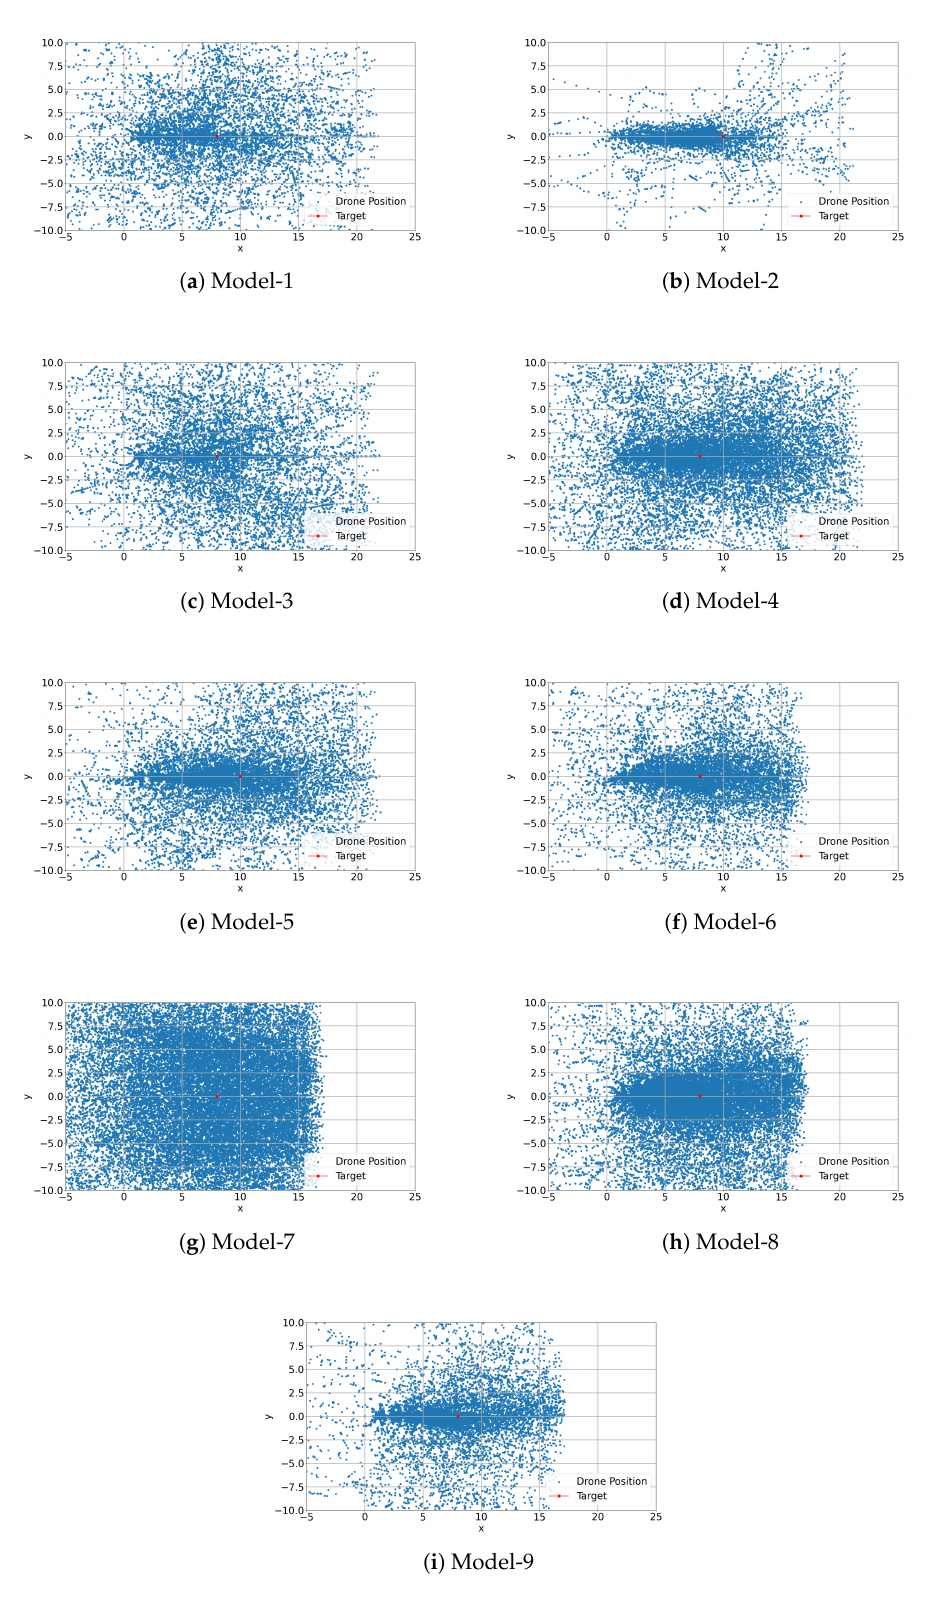
Figure A2. Drone